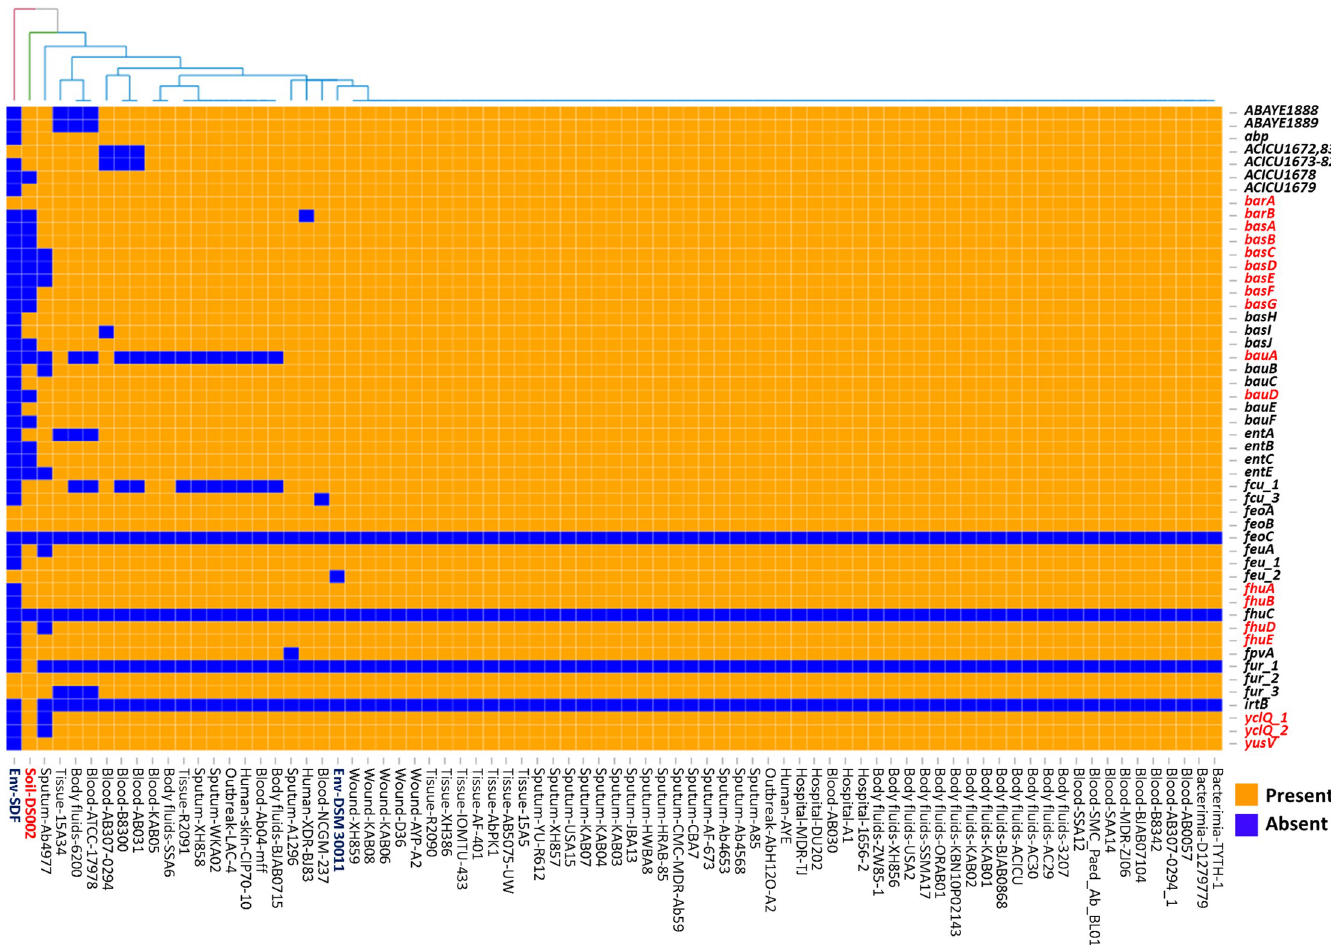
Fig 7. Heat map showing LS-BSR analysis of genes involved in iron acquisition. Genes extensively discussed in the text as well as the strain DS002 are highlighted in red font.